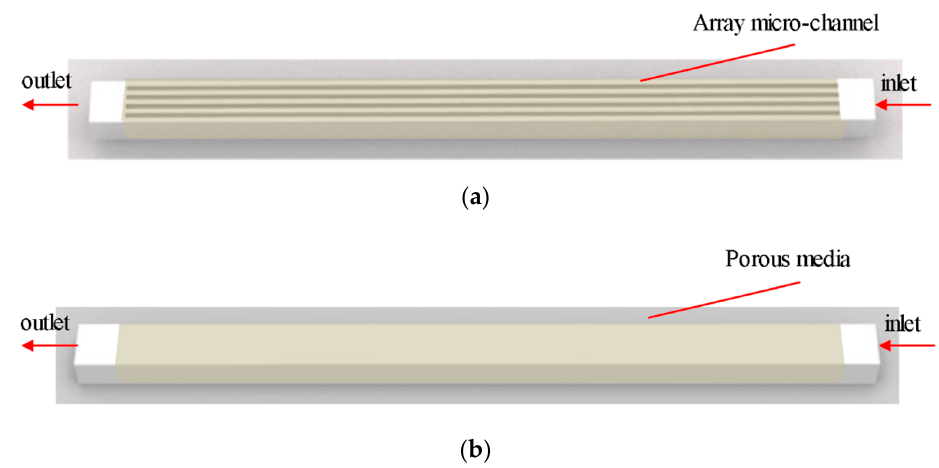
Figure 1. Schematic of the single-phase flow model: ( a ) The brown part of the figure is a microchannel; ( b ) The brown part of the figure is porous media. The inlet and outlet are indicated by the arrows.